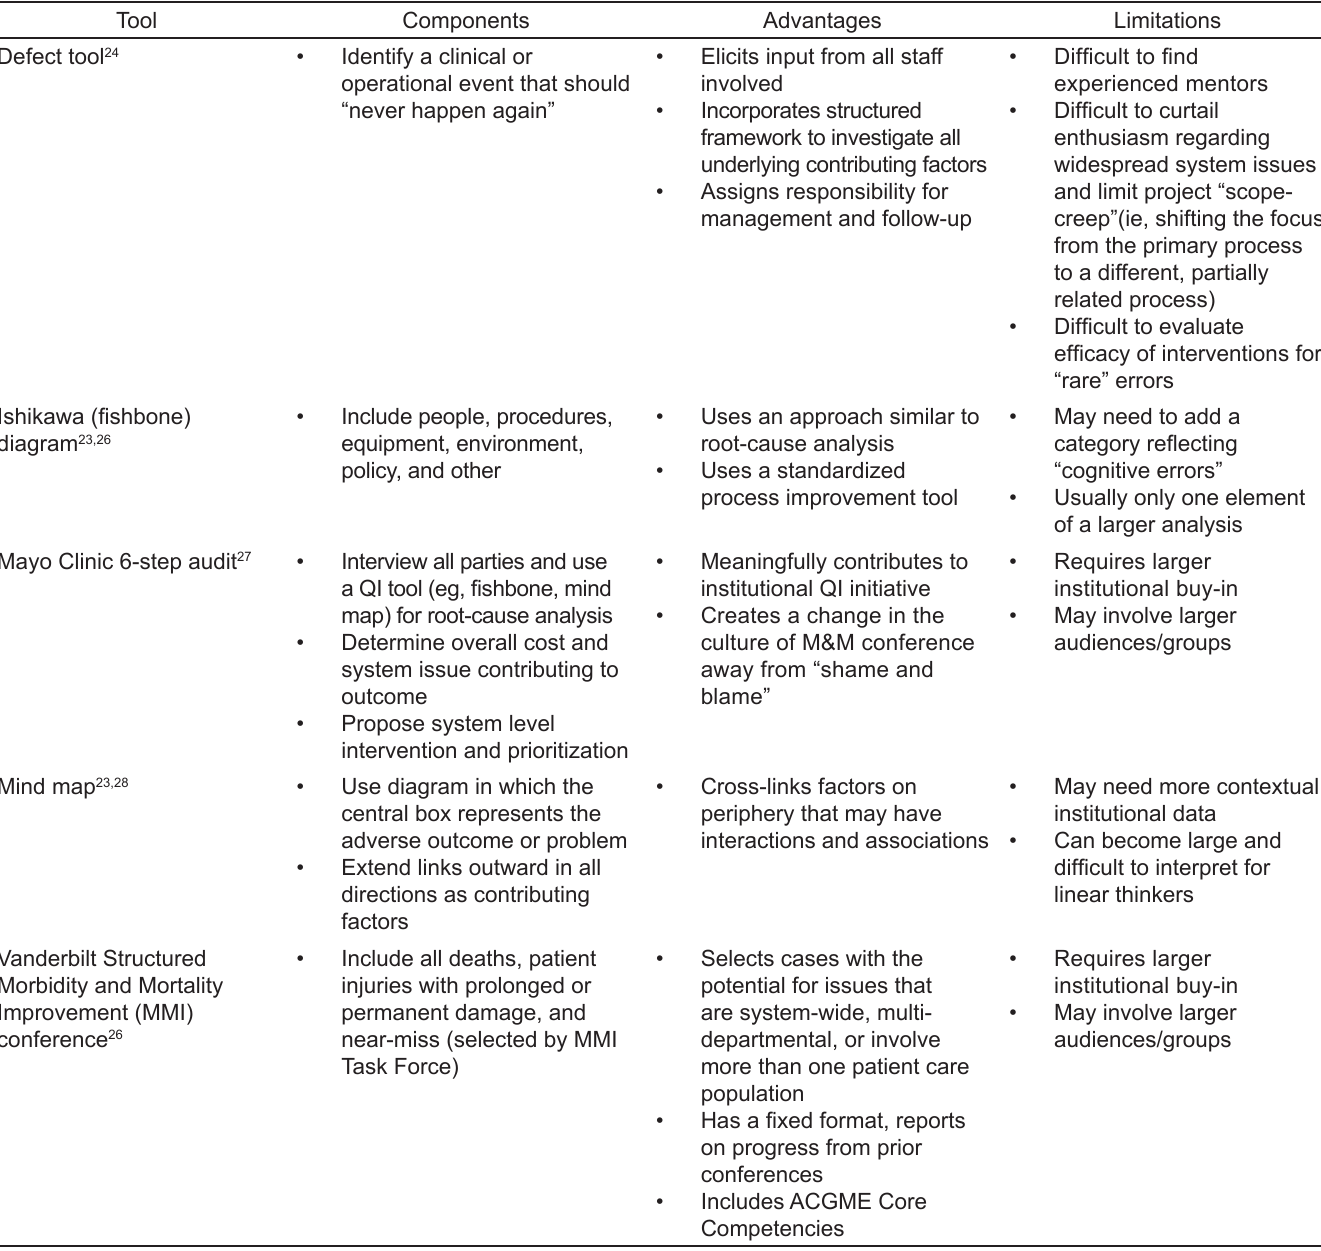
Table 5. Select case analysis